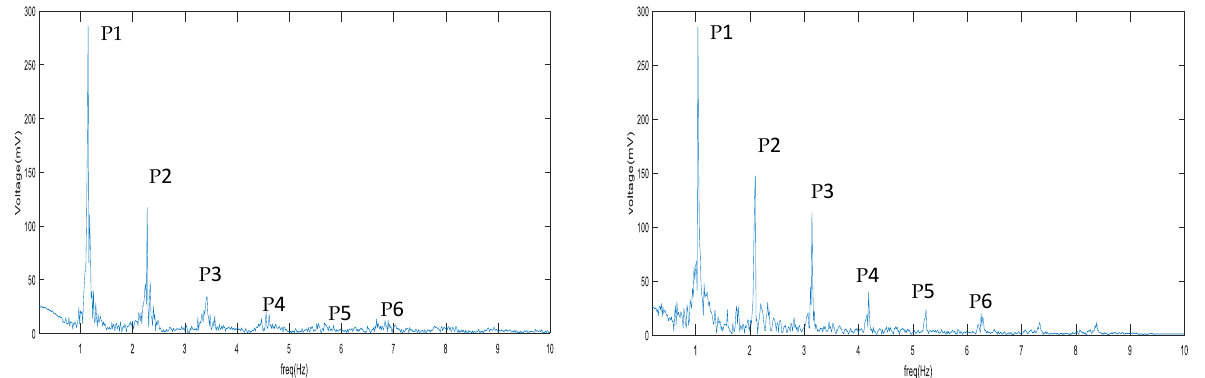
Figure 4. FFT spectrum of normal AVF wall motion signal (left), FFT spectrum of abnormal AVF wall motion signal (right). Table 1. Independent T-test of the mean difference in harmonic ratios between low flow cases and high flow cases relative to cutoff values at 600 and 750 mL/min (referenced in Figure 4). Notice symbol * represents the p -value < 0.05. ≤ 600 (n = 11) Harmonic Ratio